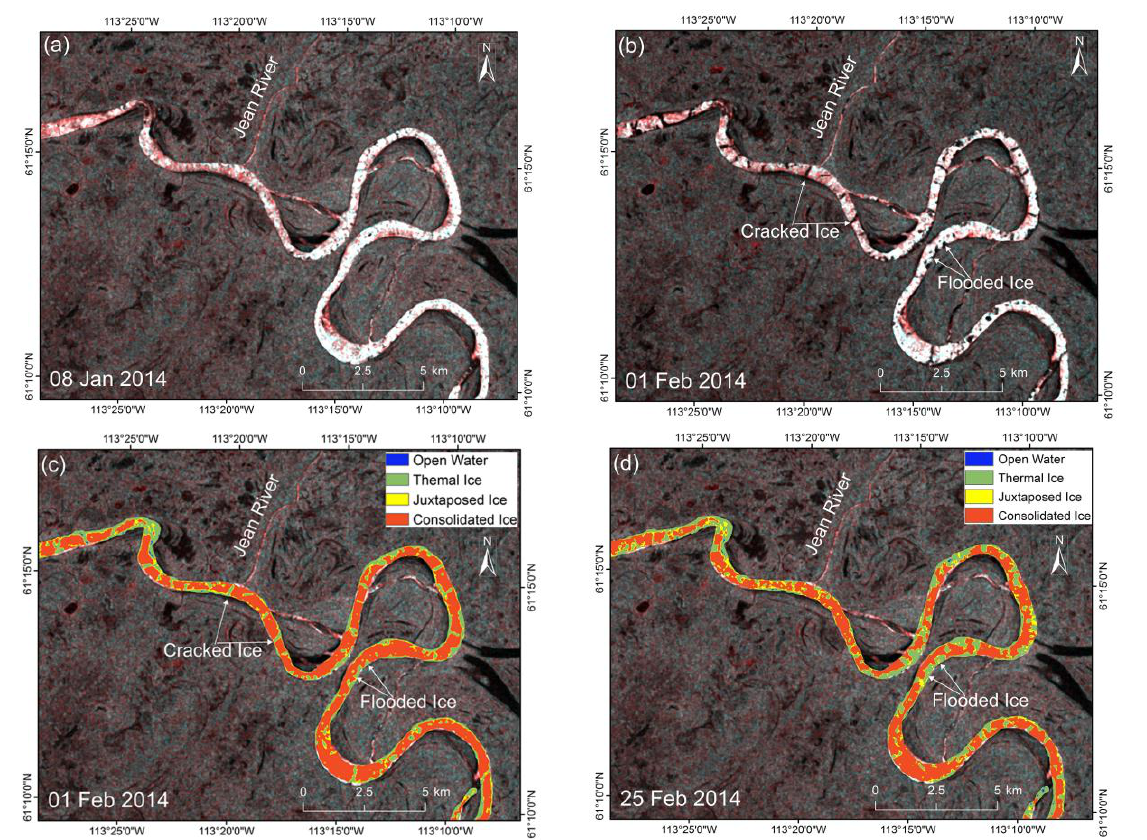
Figure 15. Occurrence of flooded/cracked areas along the Slave River Delta channel during winter 2013–2014. RADARSAT-2 images without and with flooded/cracked areas of ice cover acquired on 08 January 2014 ( a ) and 1 February 2014 ( b ), respectively, and classification of ice covers on 1 February 2014 ( c ) and 25 February 2014 ( d ) images, identifying an increase in flooded areas as misclassification with thermal ice cover.